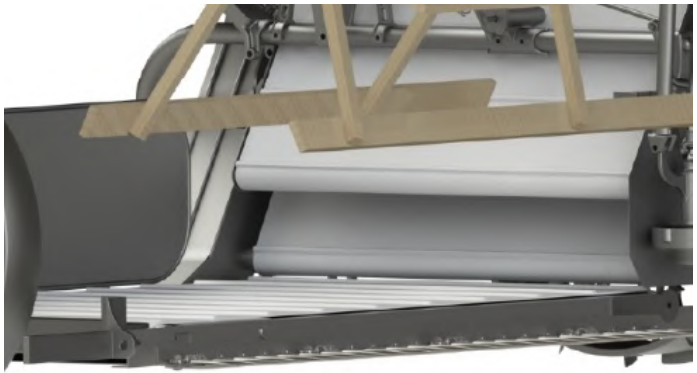
Figure 11. Bottom view of the rise conveyor system of the sheaves.